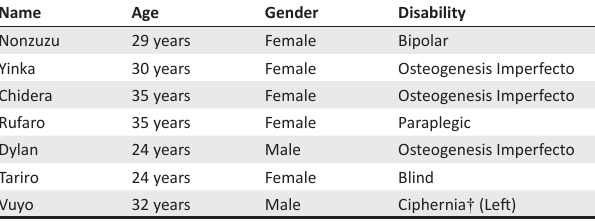
TABLE 3: Participant group 3: Artscape youth